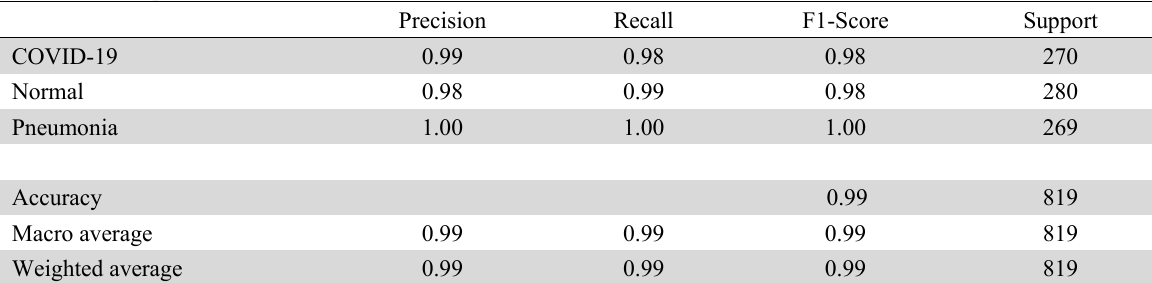
Precision Recall F1-Score Support